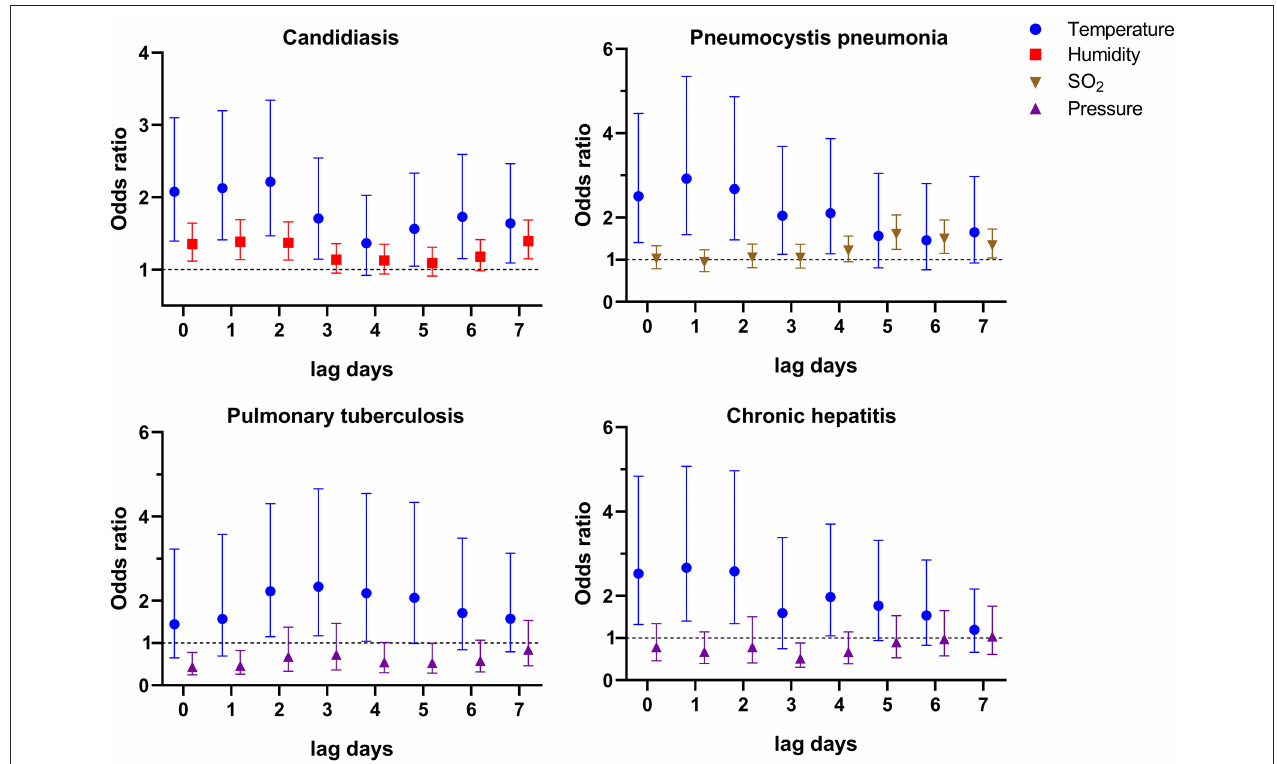
FIGURE 2 | Environmental variables significantly associated with talaromycosis hospitalizations of HIV-infected patients with co-infections.